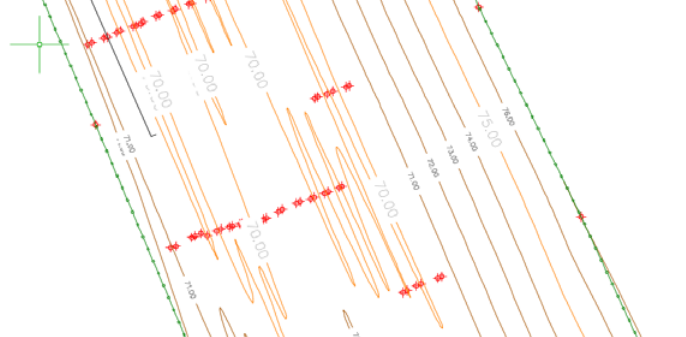
Figure 27 – Model display via contour lines - equidistance 1.0 m